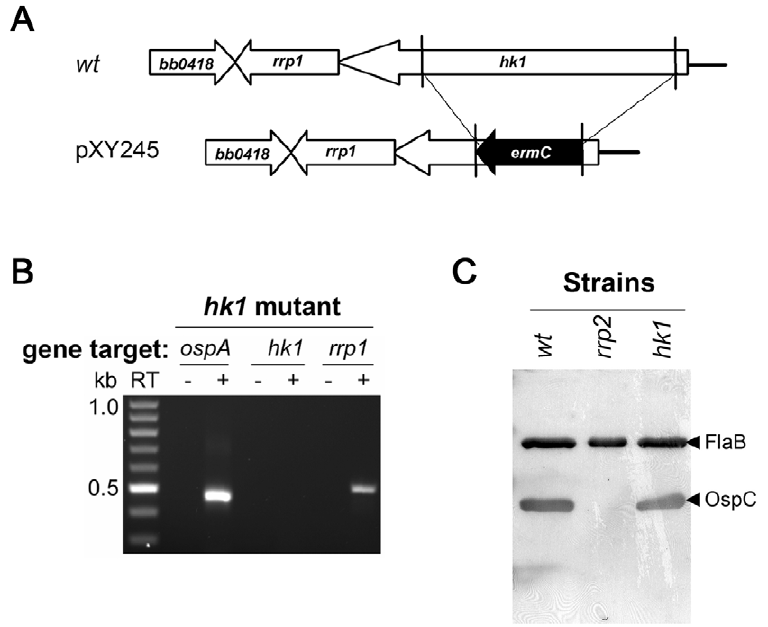
Figure 3. The hk1 mutant remains capable of activating the Rrp2-RpoN-RpoS pathway. ( A ) Strategy for insertional inactivation of hk1 . wt , genomic structure of hk1 in wild-type B. burgdorferi . pXY245, the suicide vector used for generating the hk1 mutant. Only the relevant portion of the plasmid is shown. ( B ) Confirmation of the hk1 mutant by RT-PCR analyses. RT-PCR was performed using primers specific for ospA , hk1 , or rrp1 (labeled on the top). kb: the kilobase DNA ladder. RT indicates the absence (-) or presence ( + ) of reverse transcriptase in the reaction. ( C ) Production of OspC by the hk1 mutant. Various strains of spirochetes (labeled on the top) were grown at 35 u C and harvested in the late logarithmic phase (5 6 10 7 spirochetes/ml) and subjected to immunoblot analysis using a mixture of monoclonal antibodies specific for OspC and FlaB, respectively. A strain harboring a G239C point mutation within Rrp2 [18], serves as a negative control for OspC expression. The bands corresponding to OspC or FlaB are indicated by the arrowhead on the